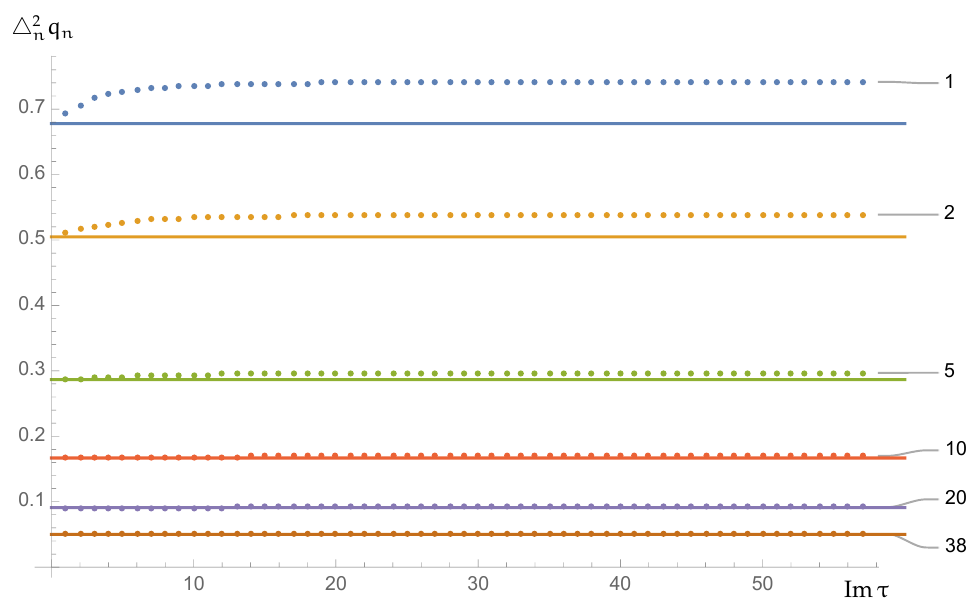
2 2 q (loc) n (dots) and for q EFT (continuous lines) as function n n n 4 4